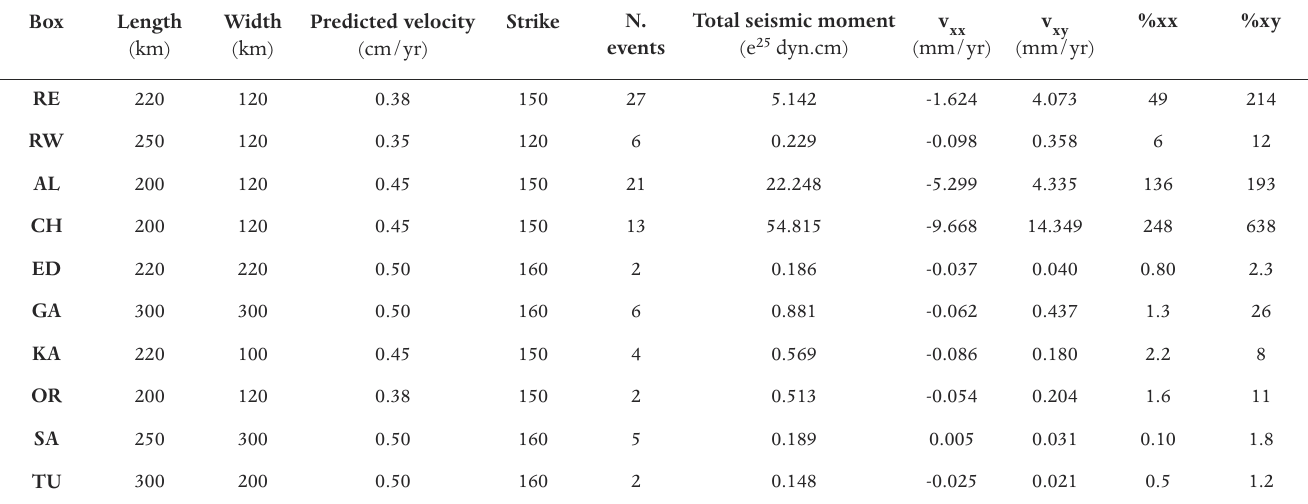
Table 1. Parameters obtained from the computation of the cumulative moment tensors. See Figure 1b for each box and tectonic zone. The length and width are for the volume V used in the summation, with the strain rate predicted by the NUVEL-1 plate tectonic model [DeMets et al. 1994). v represent the seismically inferred velocity across (v ) and along (v ) the plate boundary, with the percentages of the seismic deformation with respect xx xy to the overall deformation across (%xx) and along (%xy) the boundary also given. The reference system used is x corresponding to North-positive, y corresponding to East-positive, and z corresponding to